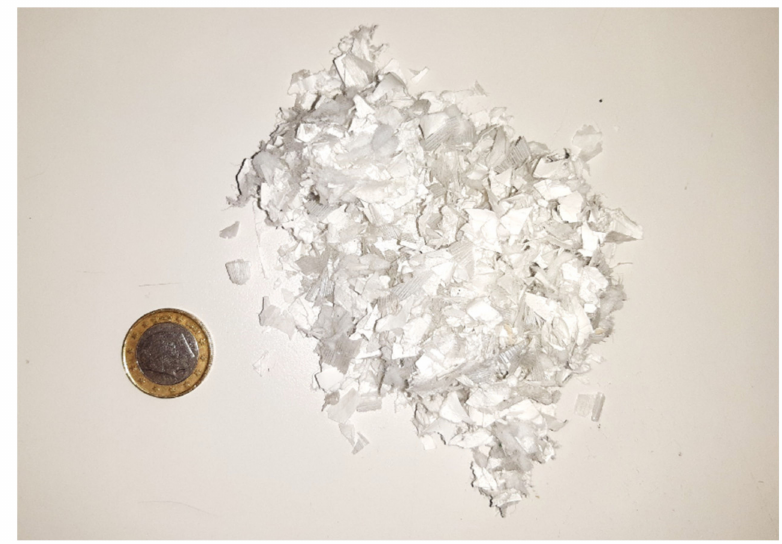
Figure 1. Shredded cigarette filters and a EUR 1 coin as size reference.